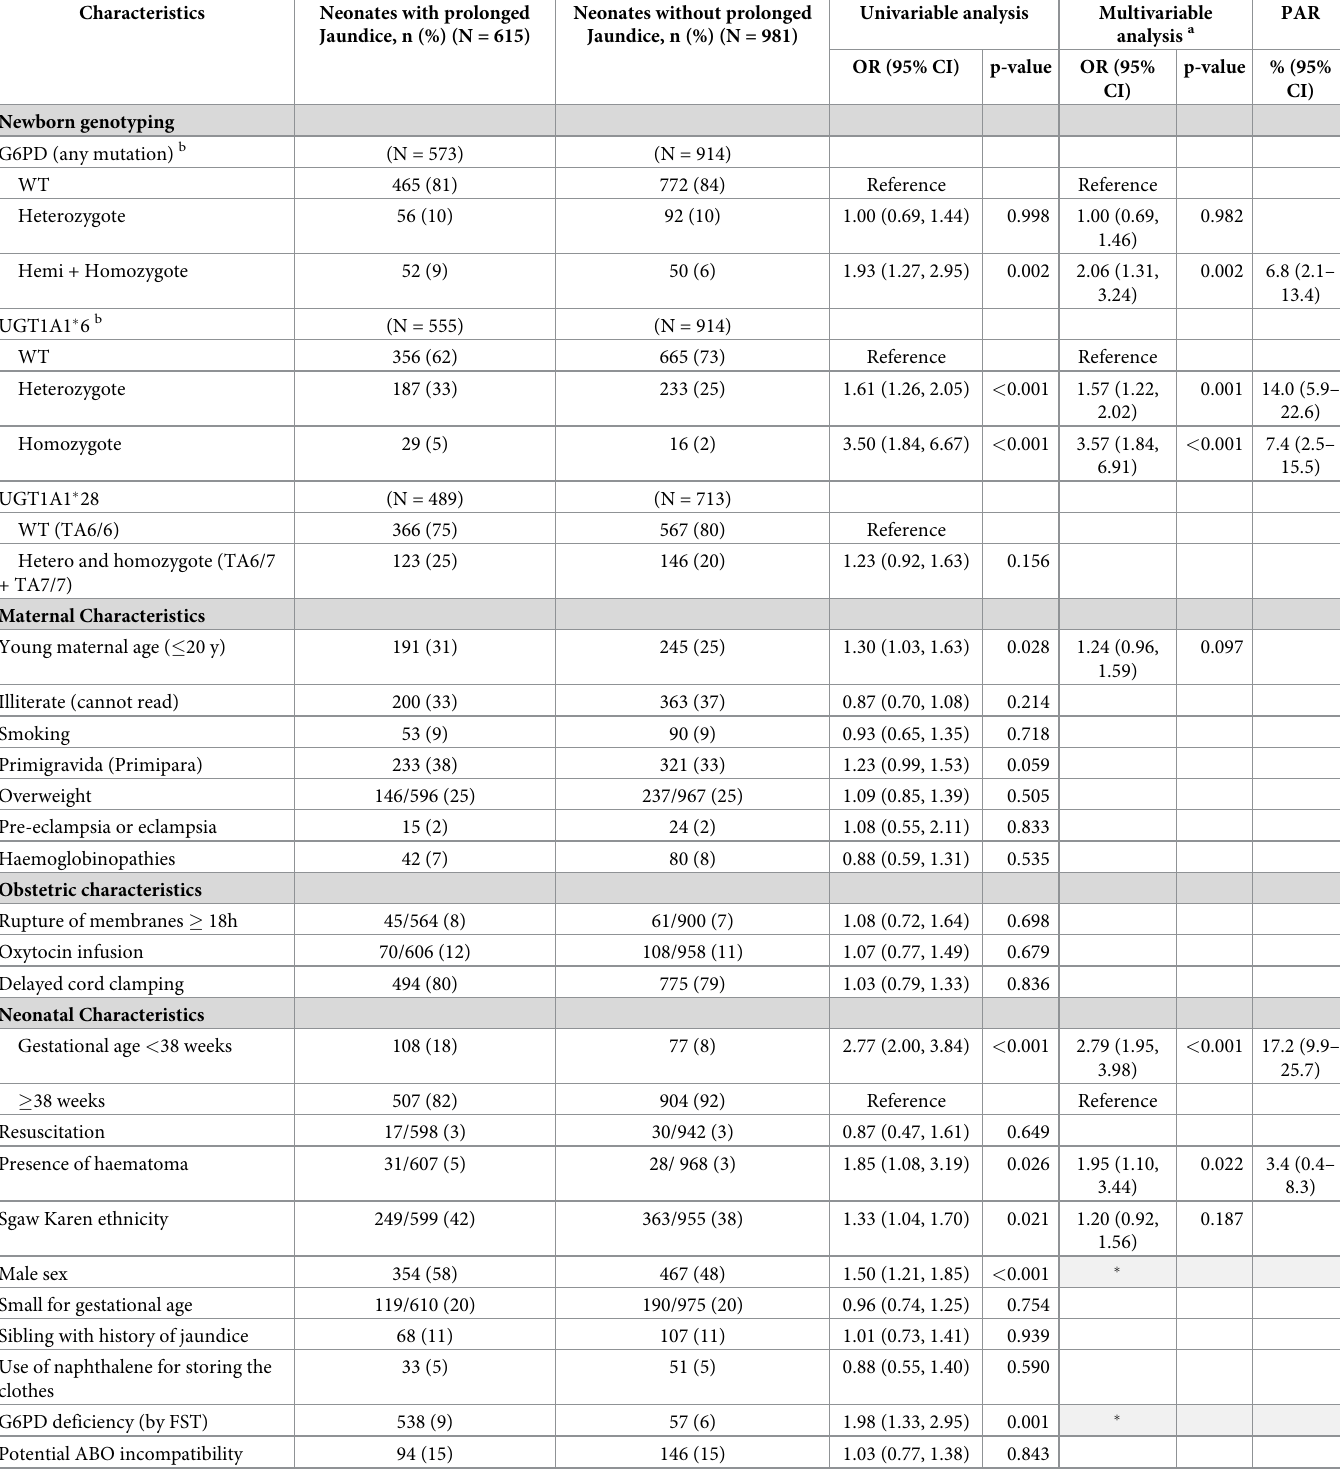
Table 5. Prolonged jaundice (between day 14–35 days): Uni- and multivariable analysis of potential risk factors and genotyping using mixed effects logistic model clustering by site.